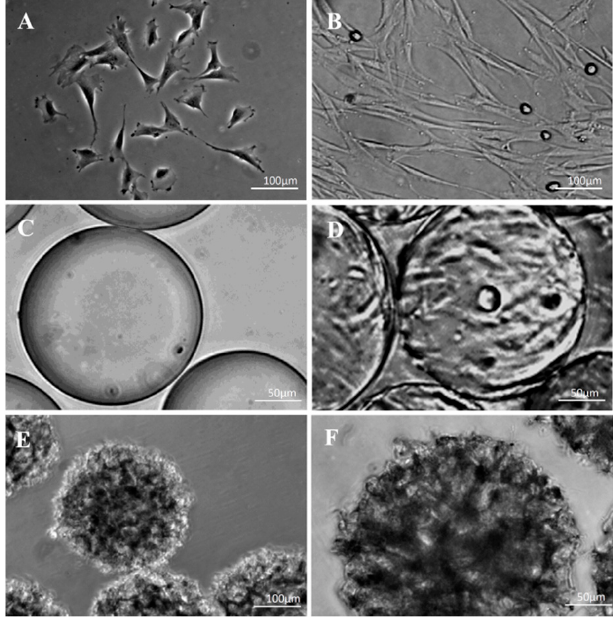
Figure 5. Phase contrast microscopy images of DPSCs grown on plastic surface and on microcarriers. ( A–B ) morphology of cultivated DPSCs on plastic surface under static conditions without microcarriers. ( C ) non-porous Cytodex 1 microcarriers. ( D ) attachment of DPSCs to the non-porous Cytodex 1 microcarriers. ( E–F ) cell attachment is not visible on Cytopore 2 because of the rough surface of this porous microcarrier. The scale bar indicates 100 µm (A,B,C,E) or 50 µm (D,F). To clearly demonstrate the presence of DPSCs on the microcarriers, a fluorescent dye, DAPI, that selectively binds to DNA, was used. Figure 6A-D clearly shows that the DPSCs are bound into the surface of both the Cytodex 1 and Cytopore 2 in fluorescence microscopy. The DPSCs were distributed evenly on the surface of Cytodex 1 (Figure 6A-